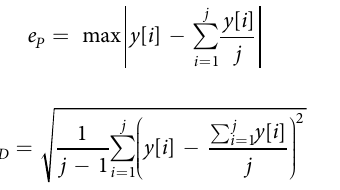
where i indicates the i th images captured during LM’s rotation in 360°, j is the total number of captured image, y [ i ] is sample’s fluctuation displacement along y axis shown in the i th image. e p represents the sample’s largest error from the mean value and e SD represents the dispersion of sample’s error about y - axis while LM rotates in